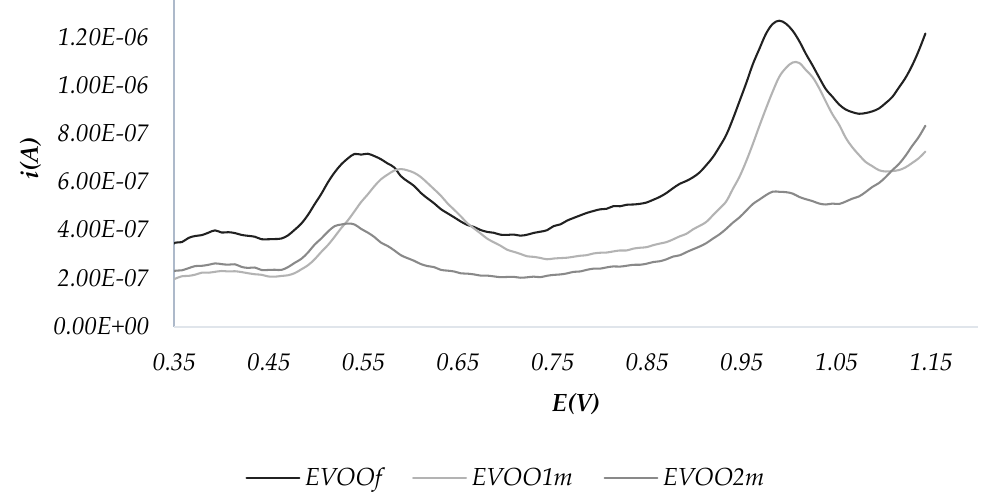
the presence of an adulteration of EVOOs.